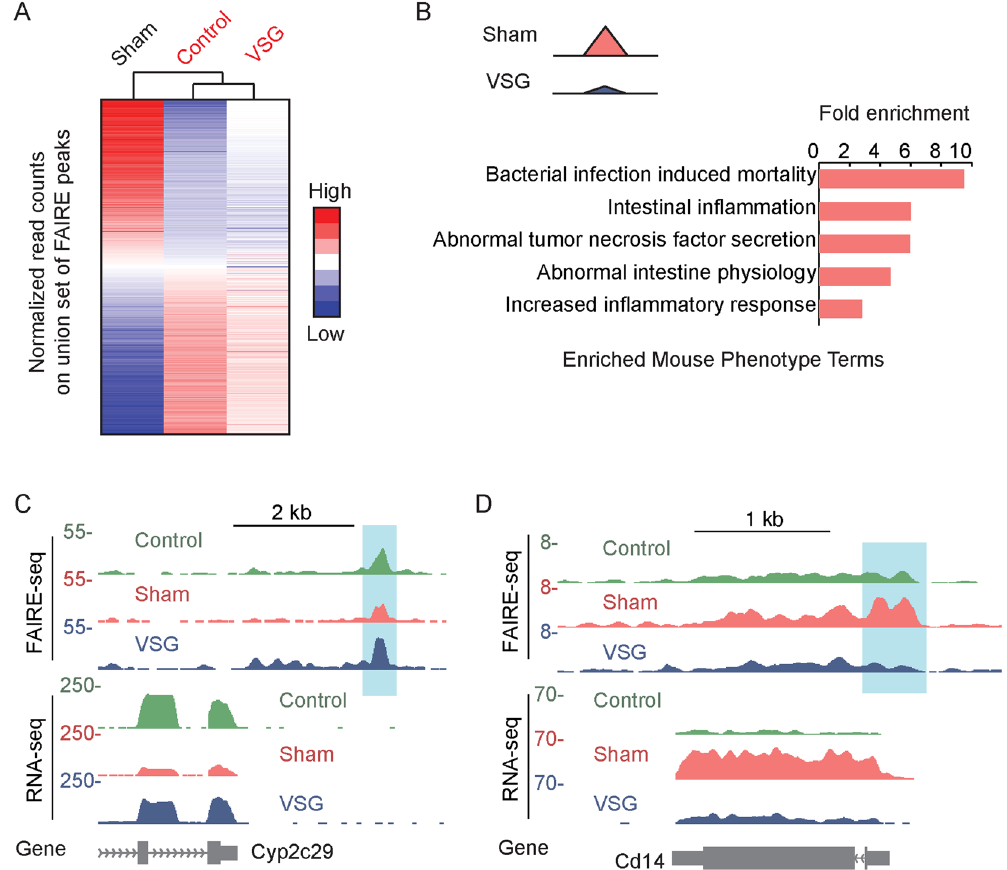
Figure 2. Reversible chromatin accessibility changes after VSG. ( A ) Heatmap of relative read counts at each peak of chromatin accessibility, sorted by relative fold change between Sham and Control group. The dendrogram above the heatmap shows the distance between Control, Sham, and VSG group characterized by read counts at each site. ( B ) Enriched mouse phenotype terms for chromatin sites that are less accessible in VSG mice compared to Sham. ( C and D ) Examples of reversible genes and accessible chromatin sites at the Cyp 2c29 ( C ) and Cd 14 ( D )